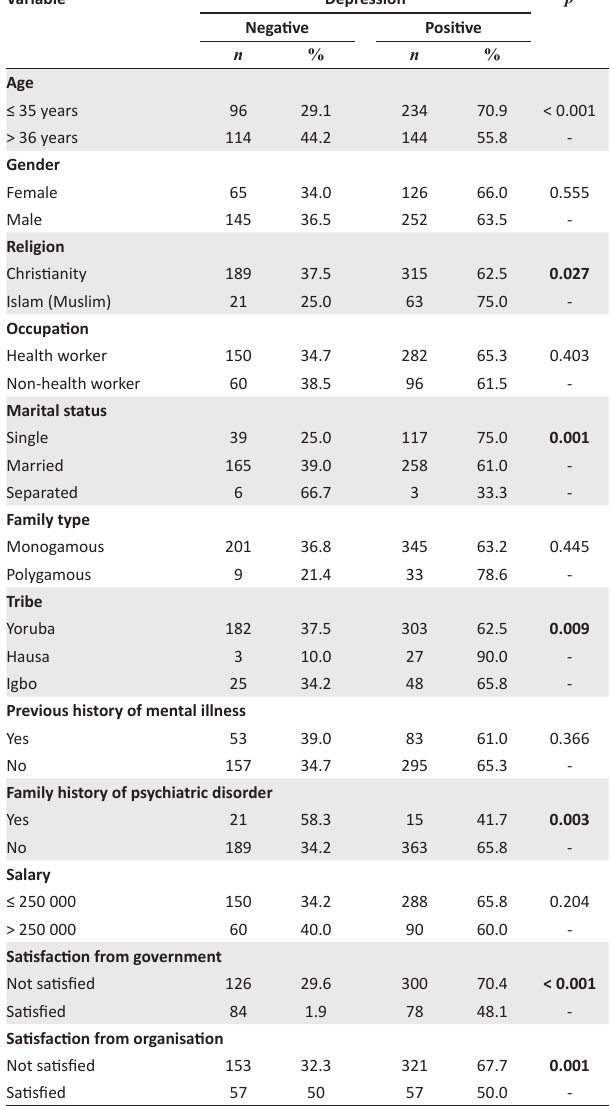
TABLE 2: Association of socio-demographic characteristics of the respondents with depression.